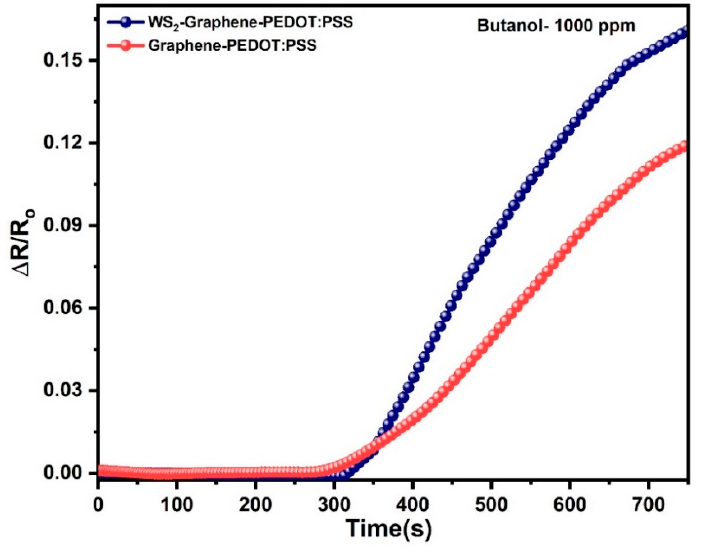
Figure 3. Response curve for butanol gas at the 1000 ppm concentration before and after the depo- sition of WS 2 nanotubes .